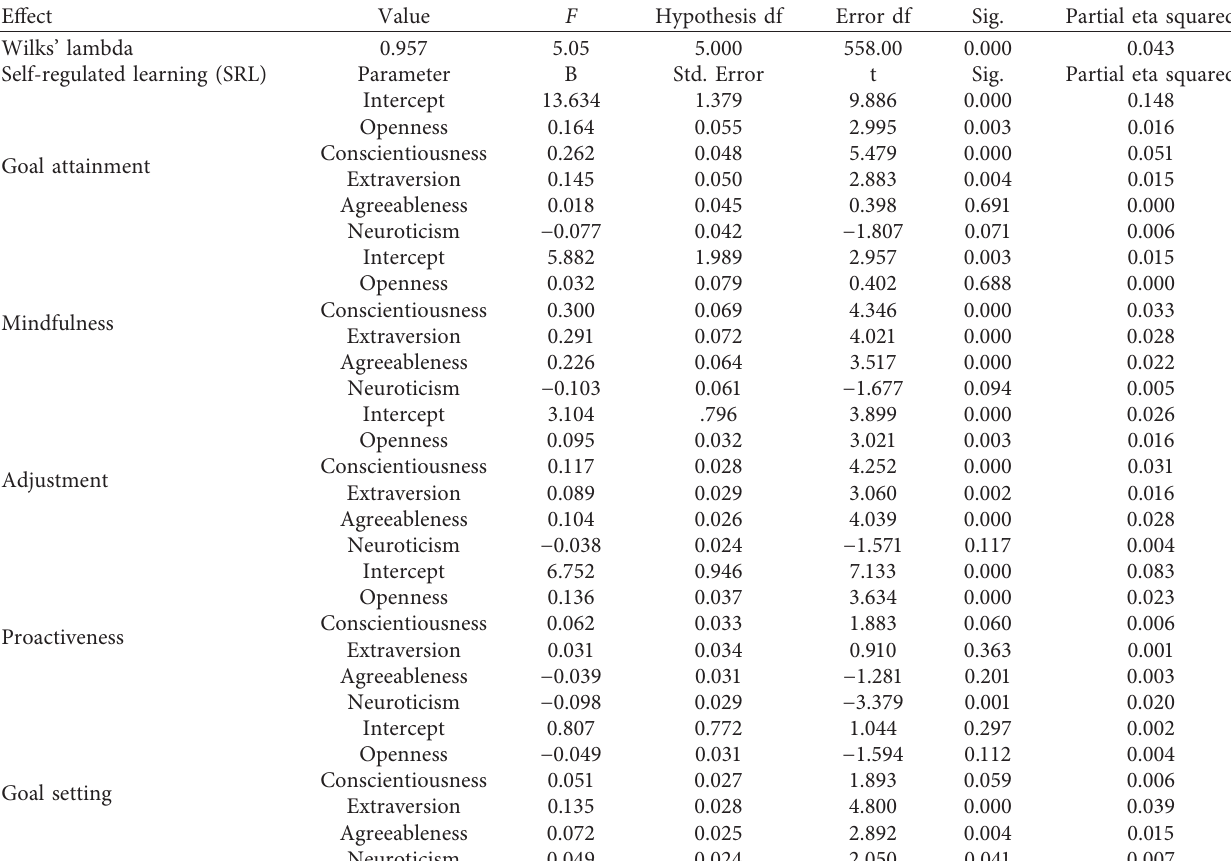
Table 3: Dimensional multivariate multiple regression (MMR) results for personality trait (PT) and self-regulated learning (SRL). Effect